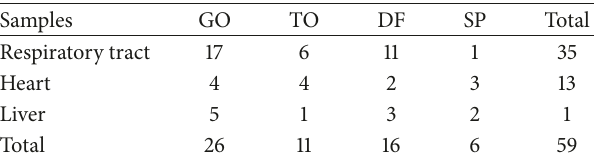
Table 1: Distribution of batches of animals to be slaughtered according to origin of sample to be collected and the state of the